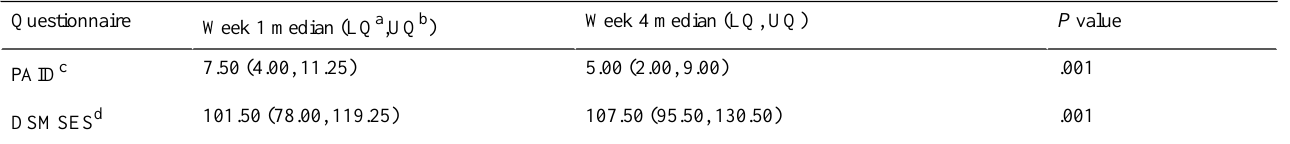
Table 4. Baseline and follow-up questionnaire